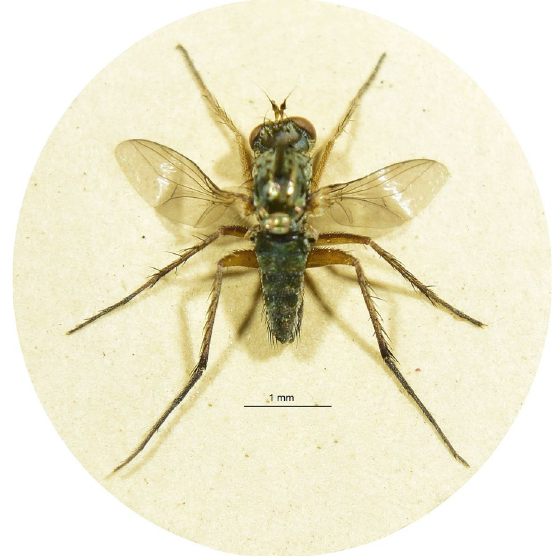
Fig. 3 Tachytrechus tessellatus (Macquart) male habitus,